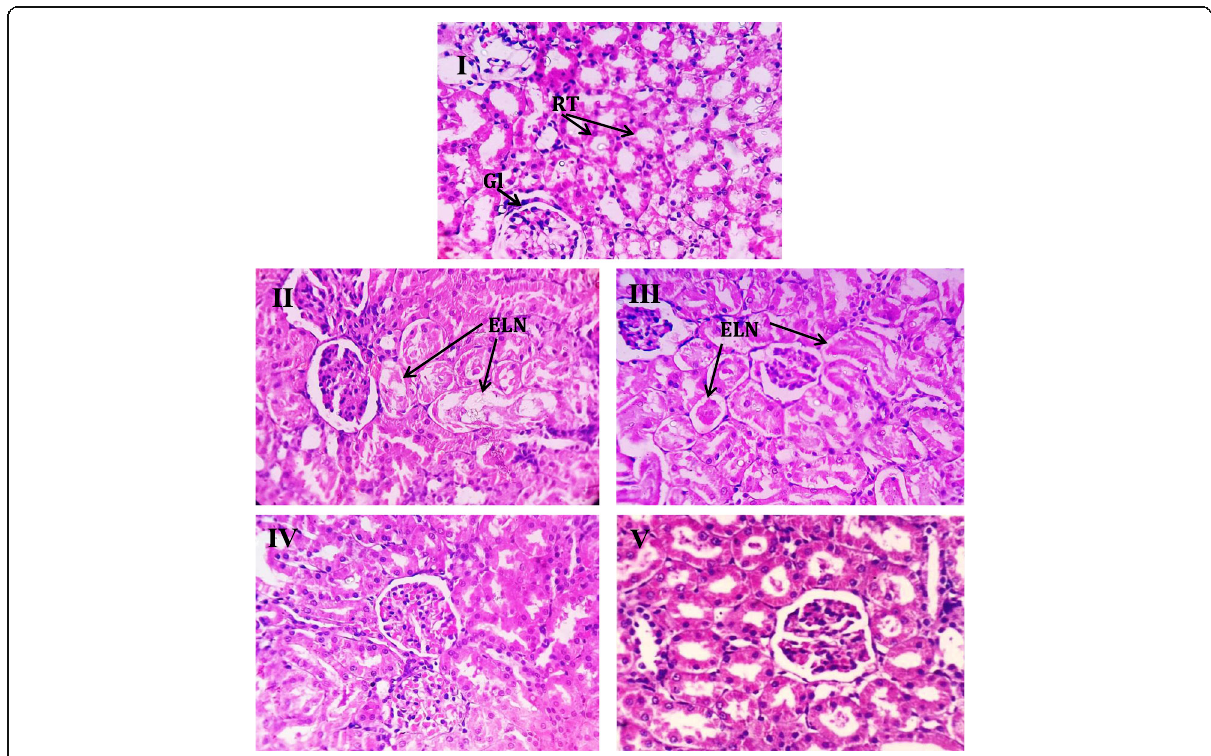
Fig. 2 Histological examination of the renal tissue of all experimental rats, at the end of experiments. I: Control rats, II: rats fed HFD without supplements, III: rats fed HFD + supplements, IV: rats fed HFD + supplements + 400mg chitosan and V: rats fed HFD + supplements + 800mg chitosan. ELN: Epithelial lining necrosis of renal tubules, Gl: glomerulus, and RT: renal tubules. Haematoxylin & Eosin,